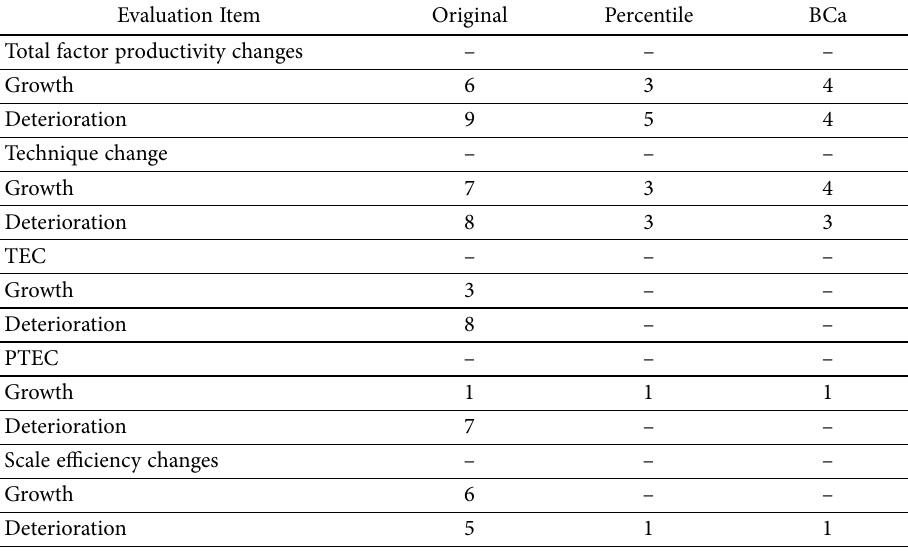
Table 16. Bootstrap and original data